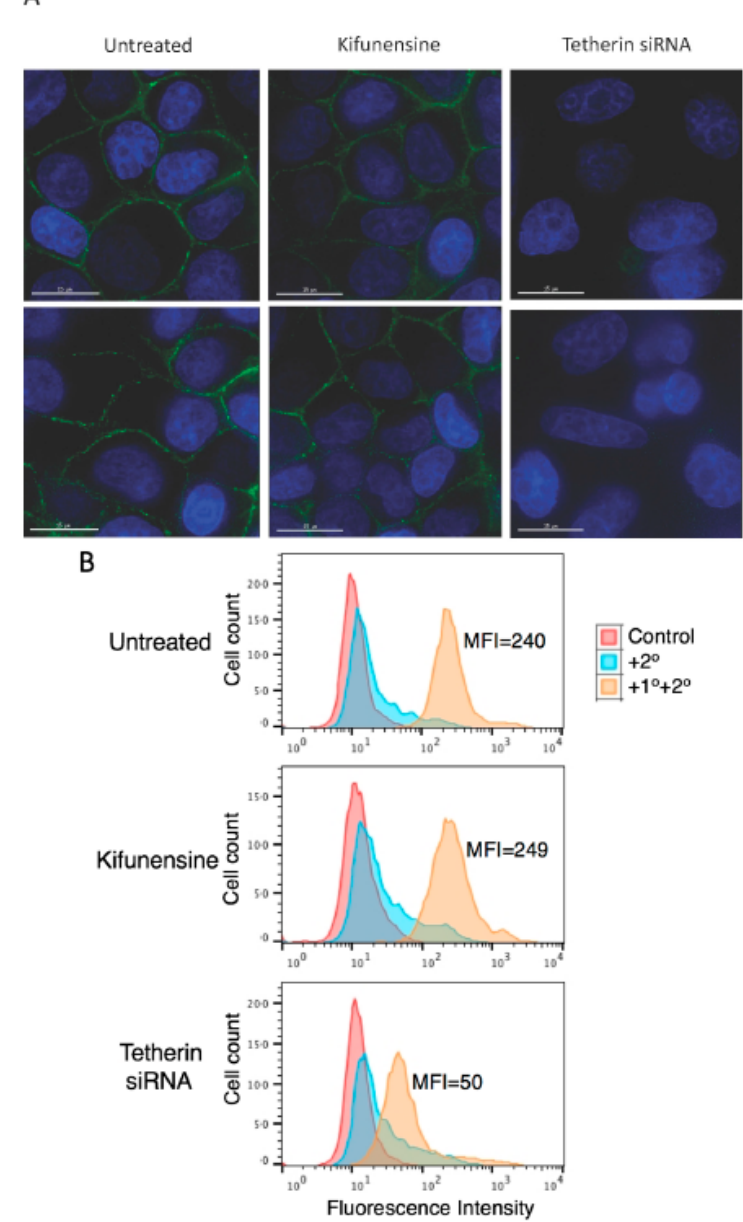
Figure 4. Complex-type glycosylation of tetherin is dispensable for tetherin cell-surface expression. ( A ) HeLa cells were plated in eight-well chamber slides; one day after plating cells were either treated with small interfering RNA (siRNA) to knock-down tetherin expression or treated with 10 µ M kifunensine for 24 h. Cells were fixed, stained with anti-tetherin primary antibodies followed by the Alexa Fluor 488-conjugated secondary antibody as detailed in the Materials and Methods Section, and were examined with a Delta-Vision RT deconvolution microscope (GE Healthcare Life Scienes, Pittsburg, PA, USA). Tetherin staining is shown in green and 4 (cid:48) ,6-diamidino-2-phenylindole (DAPI) in blue. Scale bars represent 15 µ m; ( B ) HeLa cells in 12-well plates were treated as in Figure 4A, cells were harvested and stained with anti-tetherin antisera followed by Alexa Fluor 488-conjugated secondary antibody (+1 ◦ +2 ◦ ) or were stained with secondary antibody alone (+2 ◦ ) and analyzed with a Becton Dickinson FACS Calibur flow cytometer as in Figure 2A. The number of events (cell count) is shown on the y -axis. MFI, mean fluorescence intensity; ( A , B ) Representative data from three independent experiments are